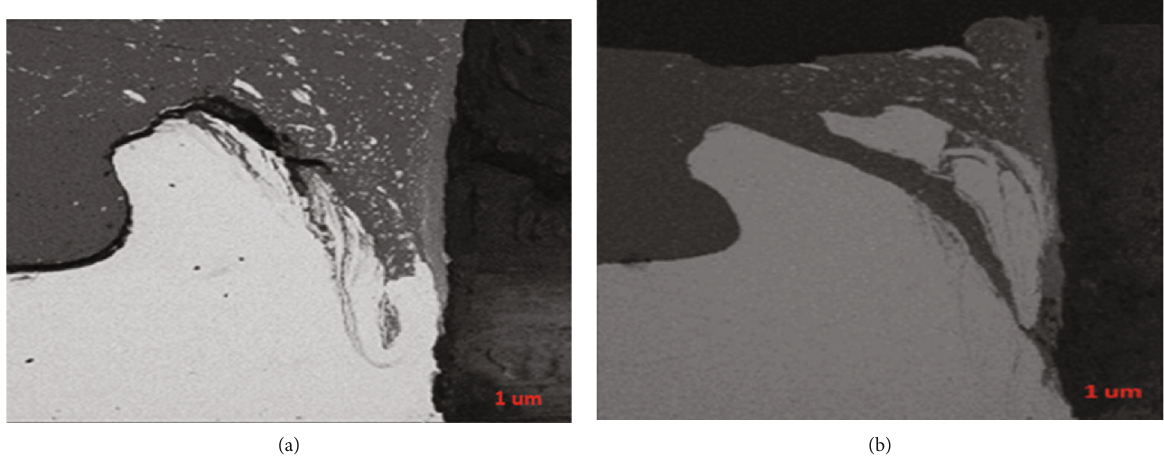
Figure 4: (a) Microstructure of the spot weld using SEM (1000rpm, 1 s and 0.5mm plunge depth). (b) Microstructure of the spot weld using SEM (1400rpm, 1 s, and 0.5mm plunge depth).